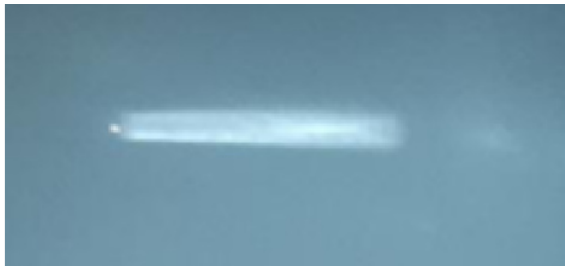
Fig. 4. Parametric fluorescence beam recorded at the exit of the BBO partial cylinder with M2 of the OPO cavity